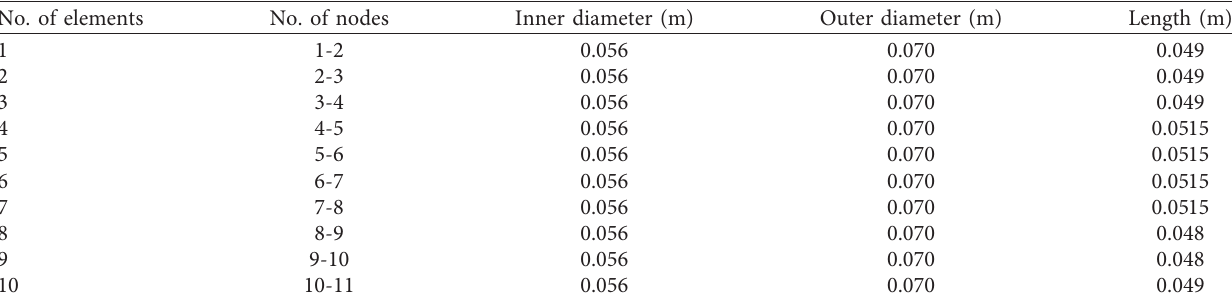
Figure 2: FE model of the rotor system. Table 3: Parameters of beam elements of the FE